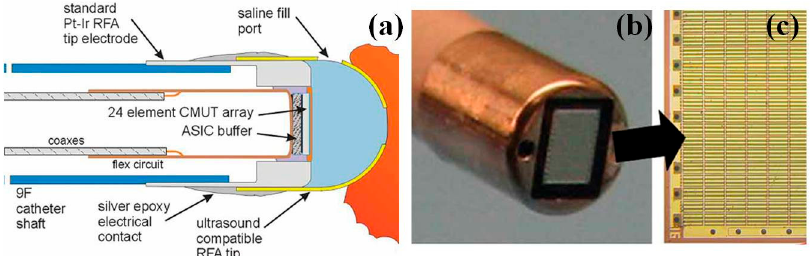
Figure 1. Capacitive micromachined ultrasound transducers (CMUTs) based ultrasound imaging catheter. ( a ) Schematic drawing of a microlinear CMUTs catheter with the special ultrasound transparent ablation tip, which contacts the endocardial wall for radiofrequency ablation (RFA) and simultaneous thermal strain echo collection. The tip thermocouple and steering assembly are omitted for clarity. ( b ) Prefinished distal tip of the 9F microlinear CMUTs intra-cardiac imaging catheter with a metal radiofrequency ablation tip electrode. ( c ) The 24-element CMUTs array with silicon die, the integrated front-end electronics are bonded underneath the array (Reproduced with permission from AIUM [27]).